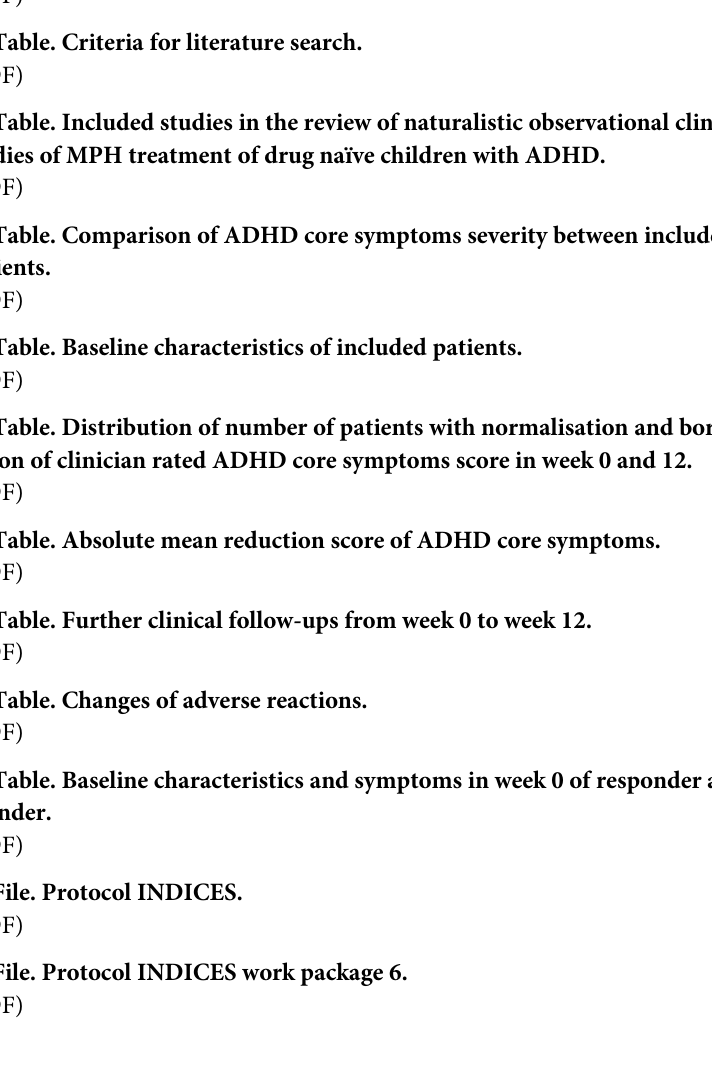
S1 Fig. PRISMA flow chart of naturalistic observational clinical prospective studies of methylphenidate treatment of children with ADHD. S1 Table. Criteria for literature search. S2 Table. Included studies in the review of naturalistic observational clinical prospective studies of MPH treatment of drug na ï ve children with ADHD. S3 Table. Comparison of ADHD core symptoms severity between included and excluded patients. S4 Table. Baseline characteristics of included patients. S5 Table. Distribution of number of patients with normalisation and borderline normali- sation of clinician rated ADHD core symptoms score in week 0 and 12. S6 Table. Absolute mean reduction score of ADHD core symptoms. S7 Table. Further clinical follow-ups from week 0 to week 12. S8 Table. Changes of adverse reactions. S9 Table. Baseline characteristics and symptoms in week 0 of responder and nonre-